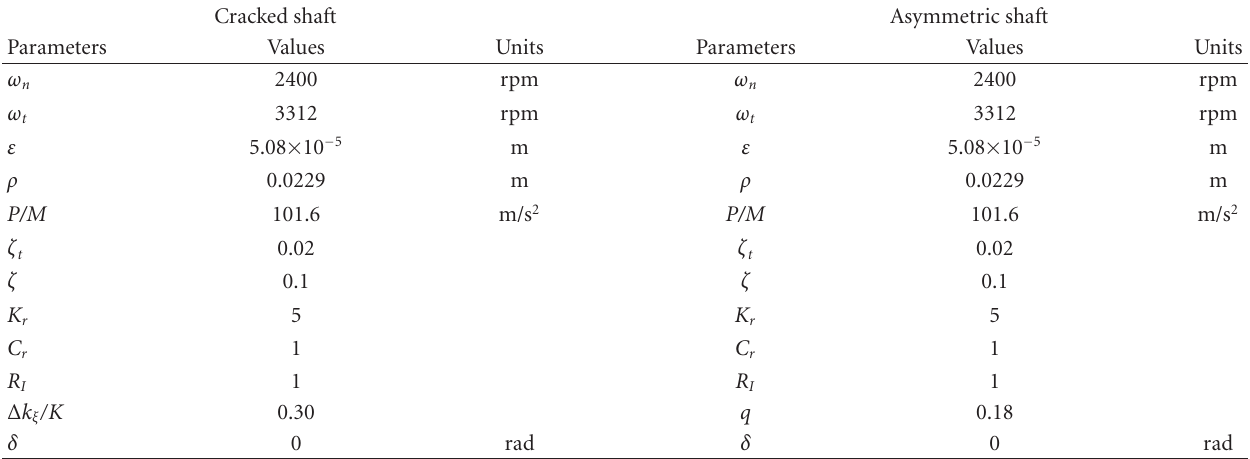
Table 3: Model physical parameters for torsional and lateral vibration, general